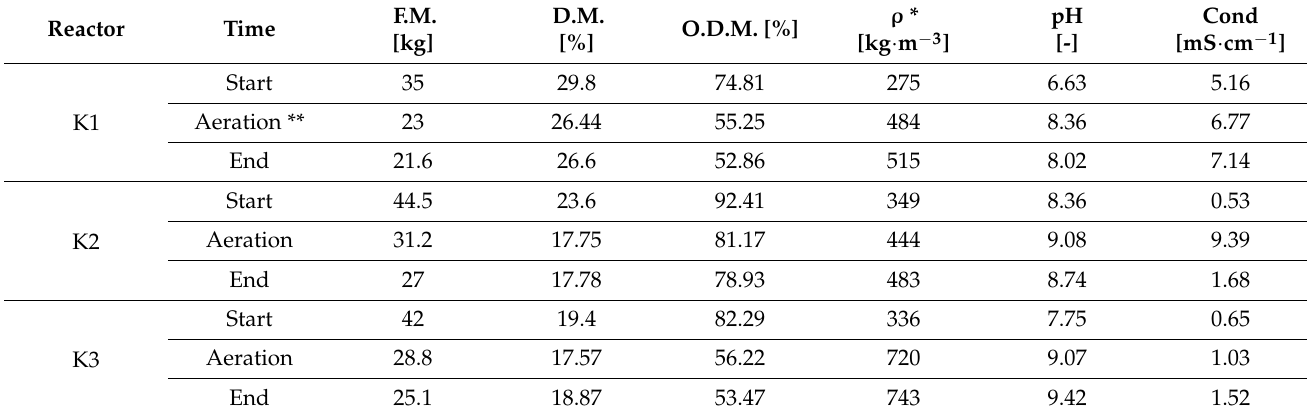
Table 2. Parameters changes during composting